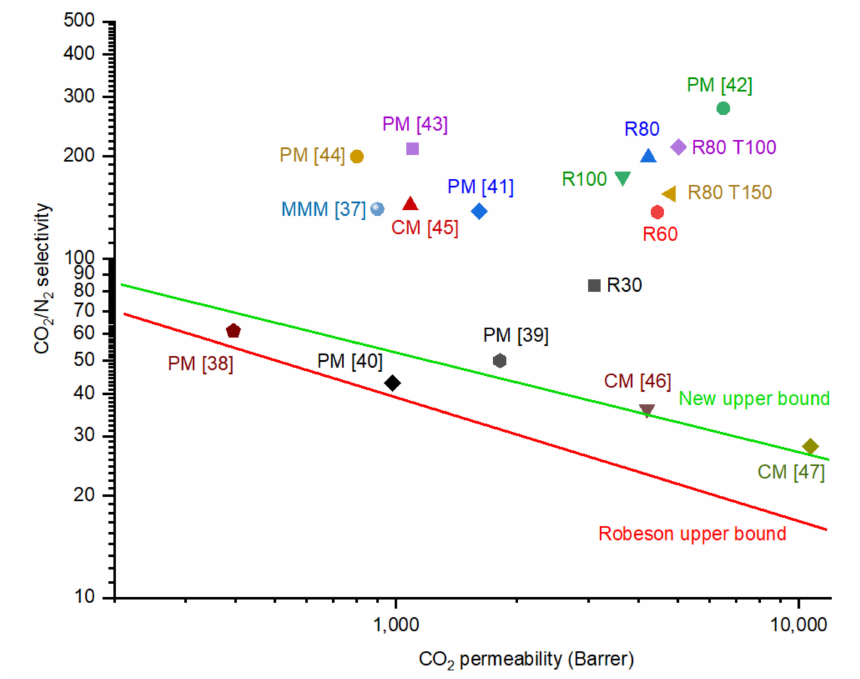
Figure 15. Comparison of performance of CMSMs (Carbon Molecular Sieve Membranes) with varying the DP (Degree of Polymerization) in the polymer and applied post treatment at permeation temperature of 75 ◦ C and 6 bar pressure difference. The comparison based on the Robson’s upper bound limit of polymeric membranes, recent Polymeric Membranes (PM), Mixed Matrix Membranes (MMM) and Carbon Membranes (CM)